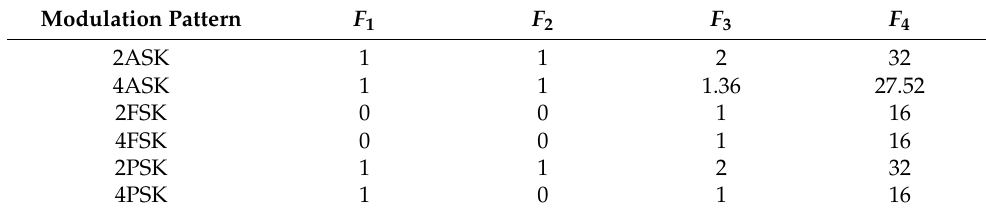
Table 1. Theoretical values of feature parameters F i of six modulation signals. Modulation